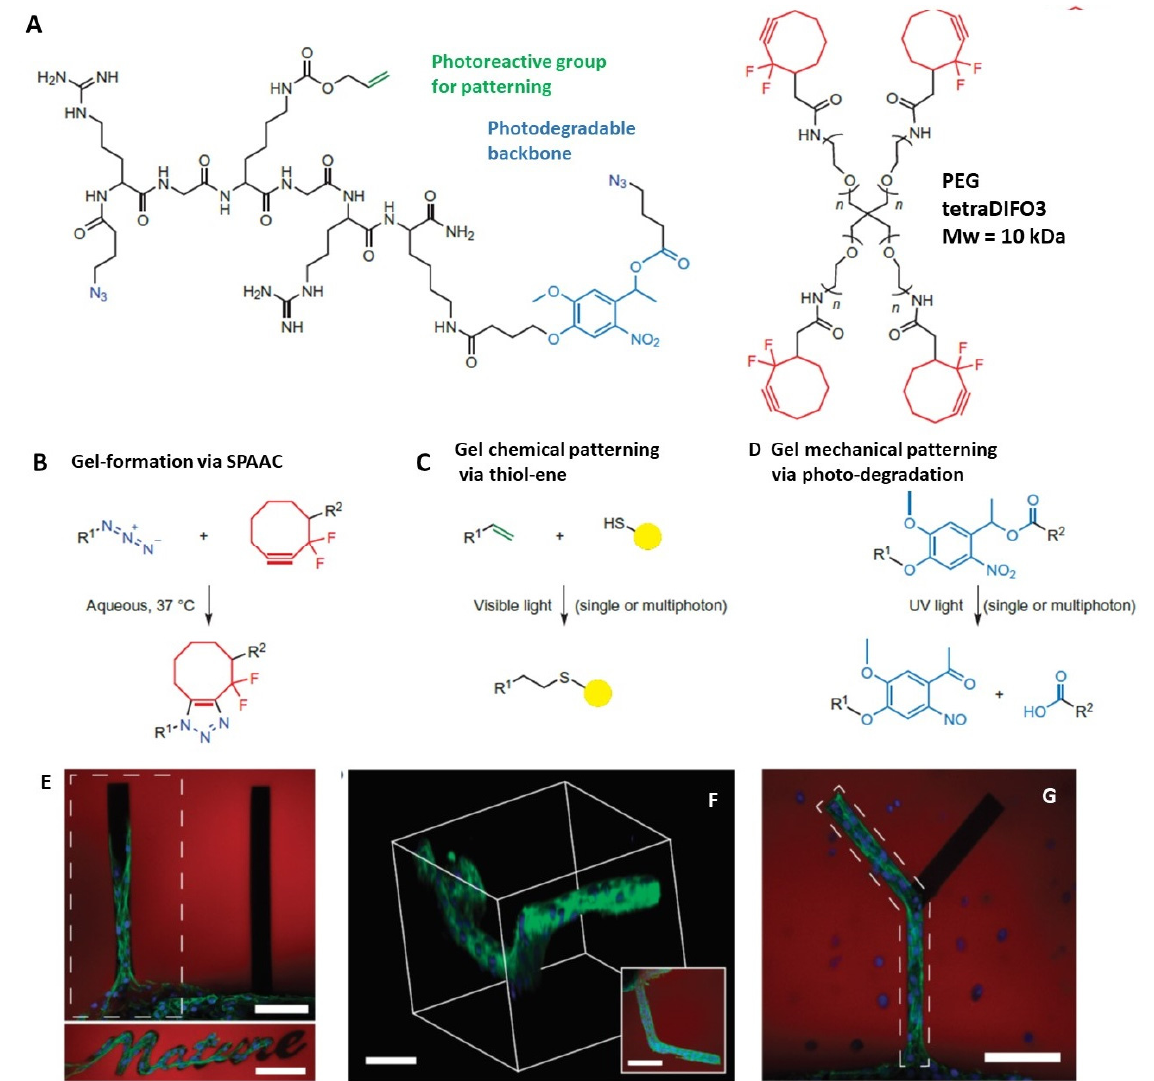
Figure 4. Photocoupling and photodegradation based on click chemistry in hydrogels. A, B, Click-functionalized macro- molecular precursors (PEG-tetraDIFO3 and bis(azide)-functionalized polypeptides) can form a 3D hydrogel structure ( A ) by means of a step-growth polymerization mechanism via ( B ) the SPAAC reaction. In the presence of visible light ( 𝜆 ≅ 490–650 nm or 860 nm, single or two-photon excitation), thiol-containing biomolecules are covalently linked ( C ) to pendant vinyl functionalities throughout the hydrogel network via the thiol–ene reaction. A nitrobenzyl ether moiety within the backbone of the polymer network undergoes photocleavage ( D ) upon single- or multiphoton absorption ( 𝜆 ≅ 365 nm or 740 nm), resulting in photodegradation of the hydrogel. ( E ): a fibrin clot containing 3T3 fibroblasts was encapsulated within the click hydrogel formulation. Chemical channels coated with RGD, a cell-adhesive fibronectin motif, were created radially out of the roughly spherical clot (bottom of the image). By day 10, cells were found to migrate only down the physical channel functionalized with RGD. ( F ): by creating 3D functionalized channels, cell outgrowth was controlled in all three spatial dimensions, with the image inset illustrating a top-down projection. ( G ): the outgrowth of 3T3 fibroblast cells was confined to branched photodegraded channels functionalized with RGD. The regions of RGD functionalization are highlighted by the dashed polygons in E and F. Hydrogel is shown in red, F-actin in green, and cell nuclei in blue. Scale bars, 100 𝜇 m. Adapted and reprinted with permission from [3].